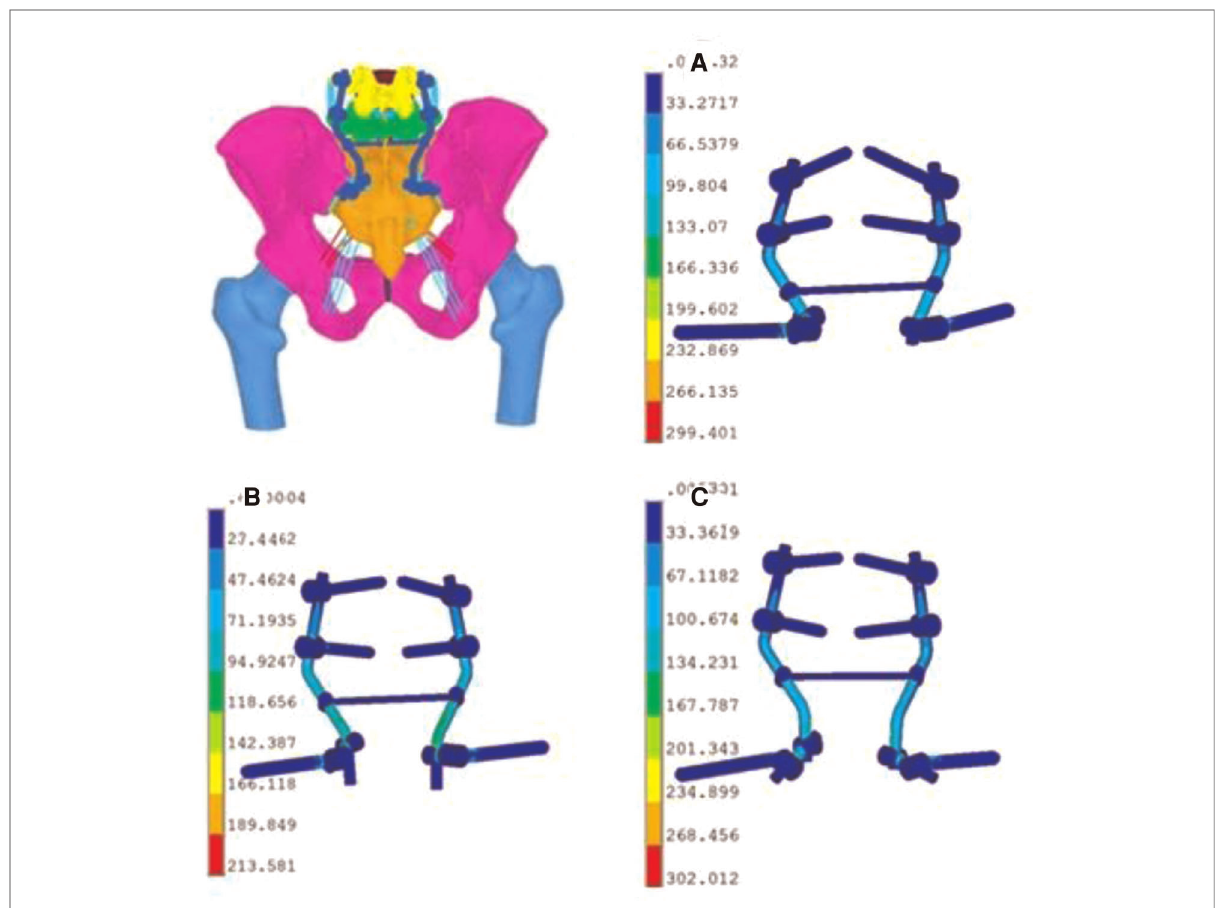
FIGURE 3 Established fi nite element model of lumbo-iliac fi xation: under the vertical working condition. ( A ) Stress distribution nephogram of internal fi xators in channel A. ( B ) Stress distribution nephogram of internal fi xators in channel B. ( C ) Stress distribution nephogram of internal fi xators in channel